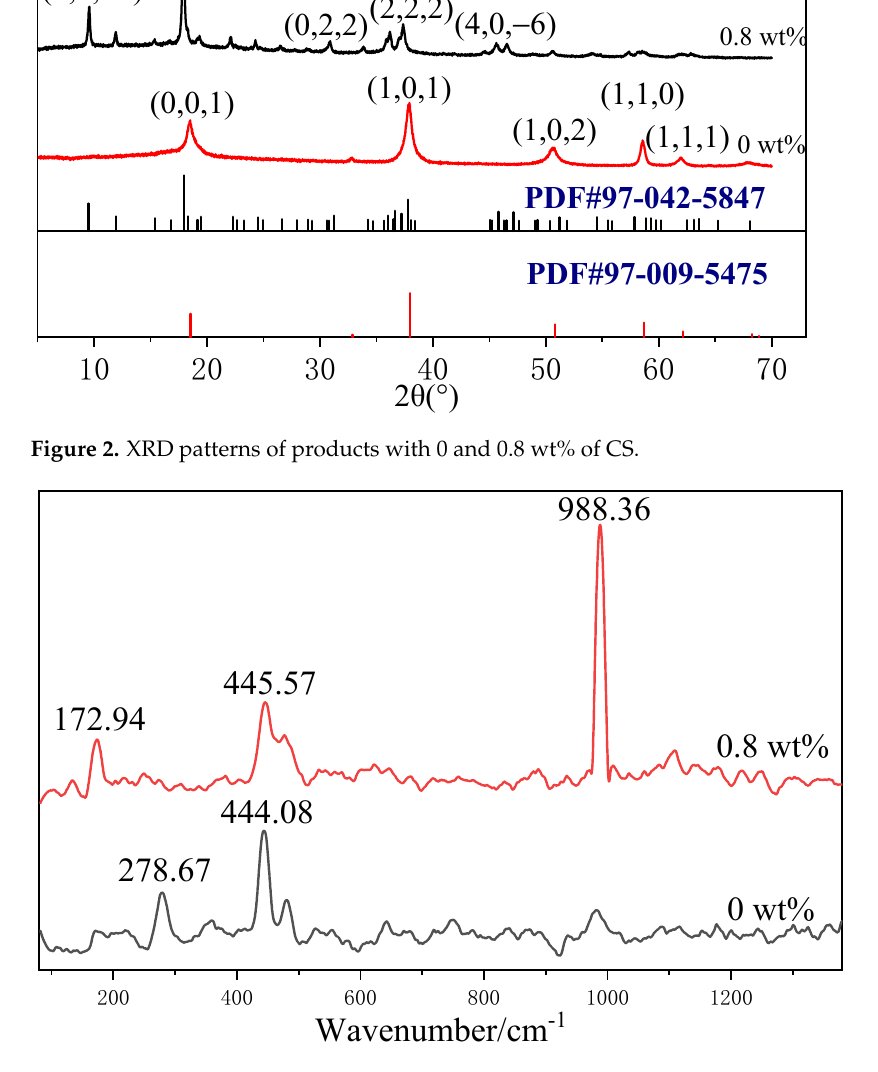
Figure 3. Raman spectra of products with 0 and 0.8 wt% of CS. According to Figure 4, at 0 wt% CS, the product was composed of Mg(OH) 2 particles. The SEM image of the product with a CS content of 0.8 wt% shows the smooth surface and neat morphology of the 517-type BMSWs with high purity.